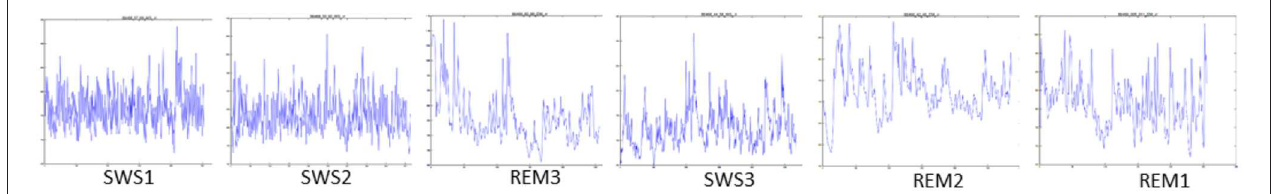
FIGURE 1 | Tachnograms in temporal order from a male participant (8.25 y, BMI 17.6), during SWS1, SWS2, REM3, SWS3, REM2, and REM1.